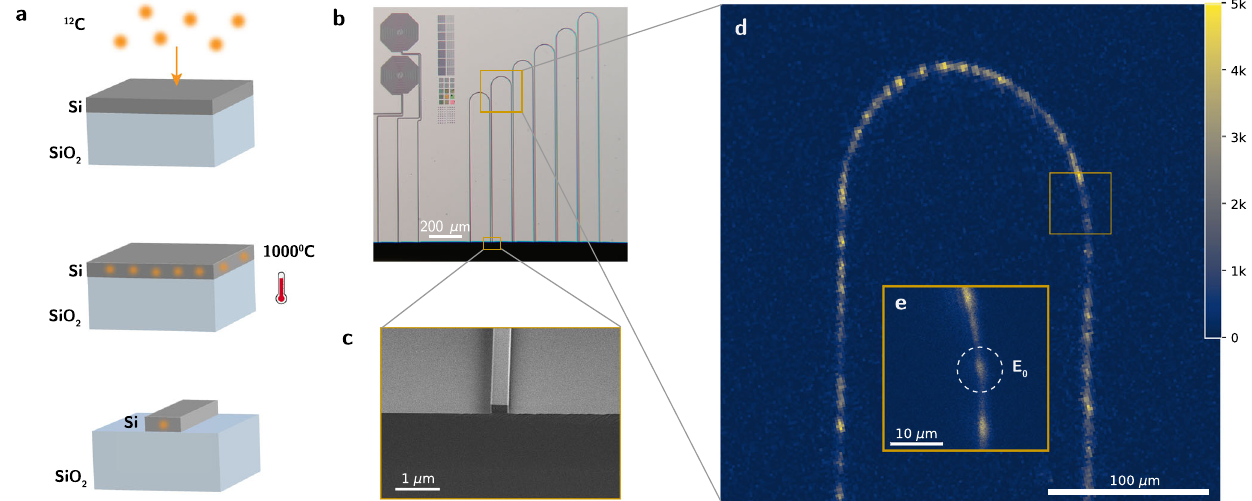
Fig. 2 | Fabrication and imaging ofG-centers in siliconphotonics.a Fabrication process for G-centers in silicon photonic waveguides. b Microscope image of our sample, showing several silicon photonic structures. c Scanning electron